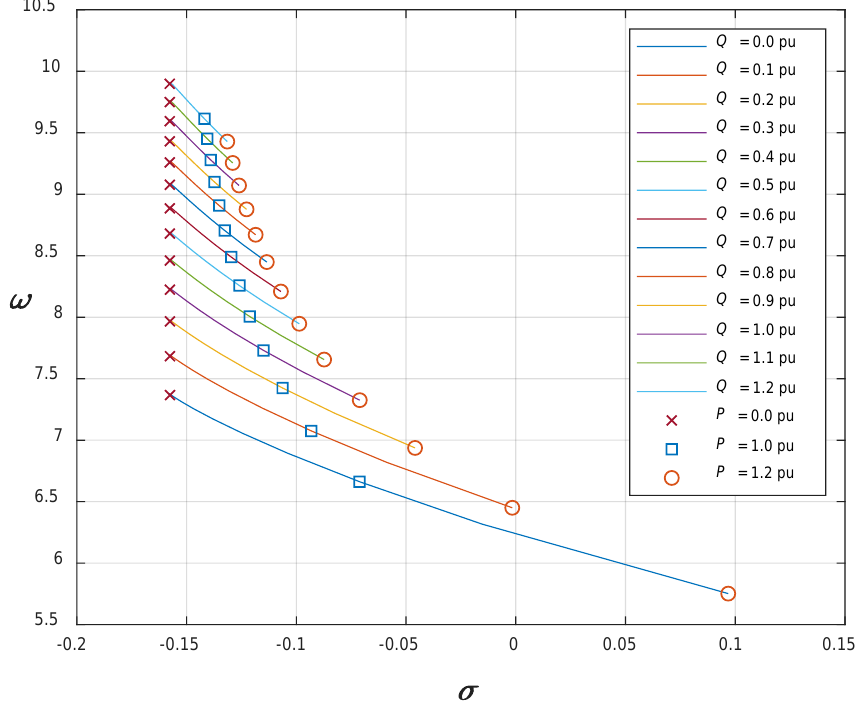
Figure 13. Eigenvalue loci of the local mode of 158-MVA hydro-type synchronous generator with AVR.